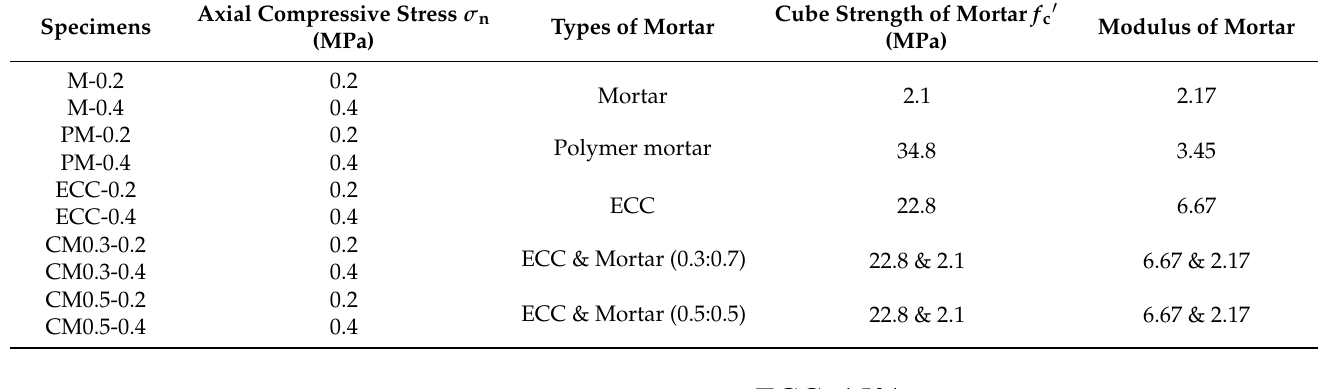
Table 1. Design parameters of the test specimens.